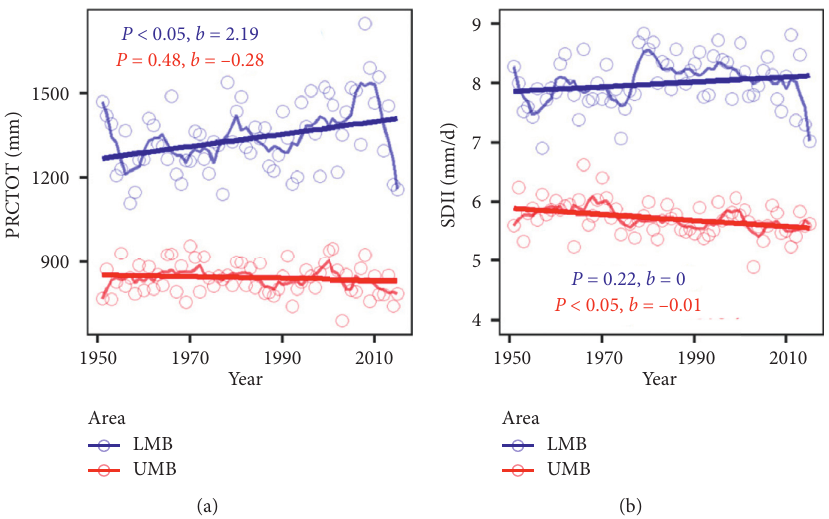
Figure 9: Temporal trends in PRCTOTand SDII averaged across the UMB and the LMB over 1951–2015. The lines represent linear trends of precipitation indices, and the polylines indicate the five-year moving averages of the